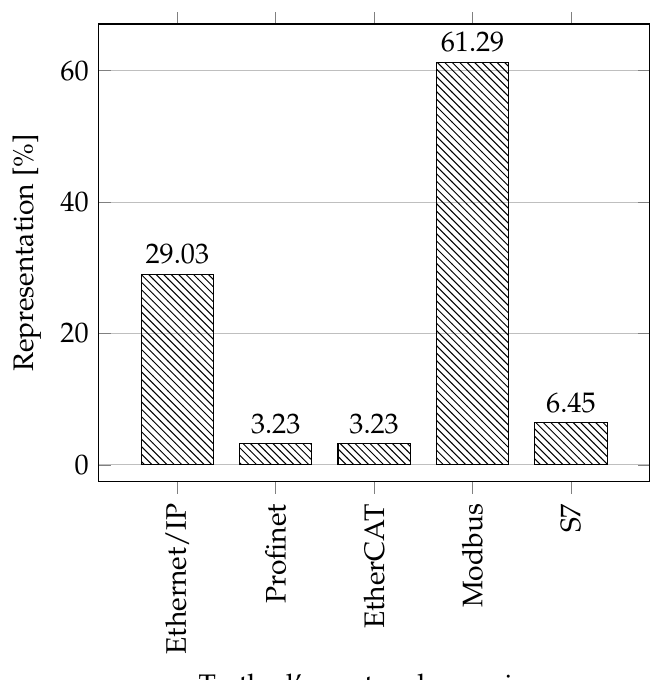
Figure 19. The percentage of selected testbeds’